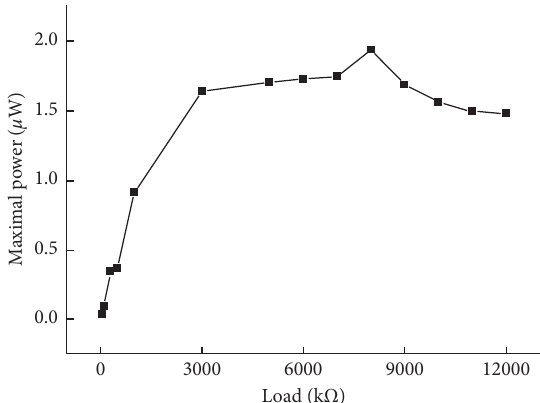
Figure 32: Relation of the maximum power and external loads of the system.